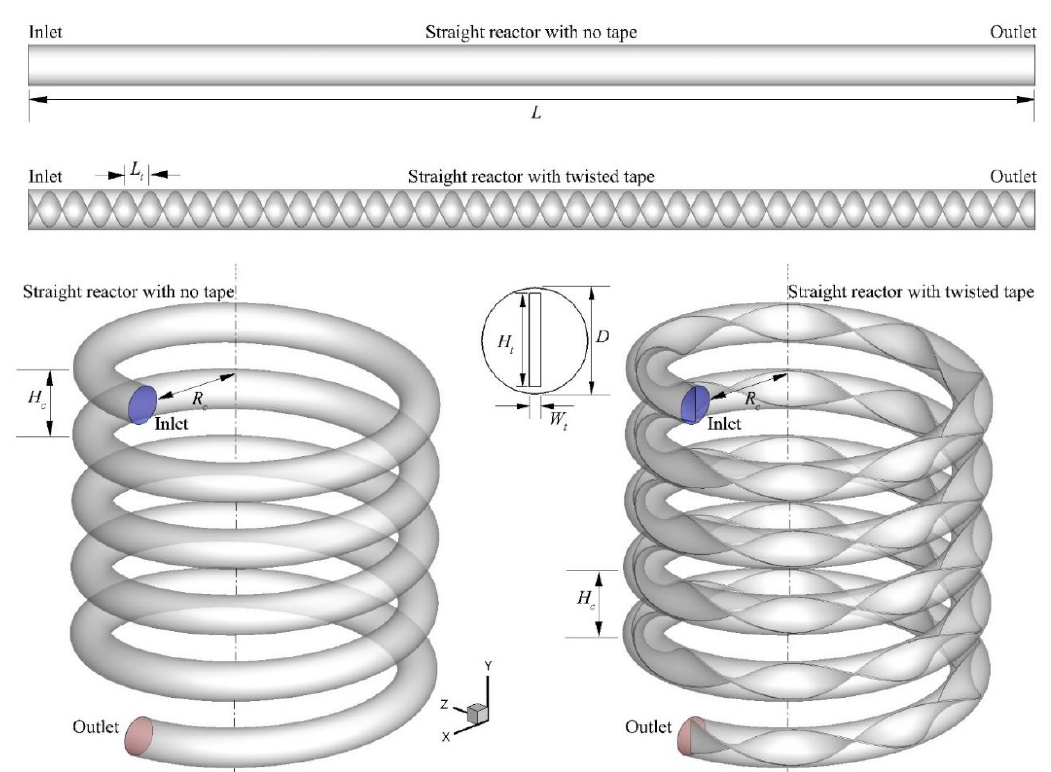
Figure 9. Schematics representation of the studied reactors.